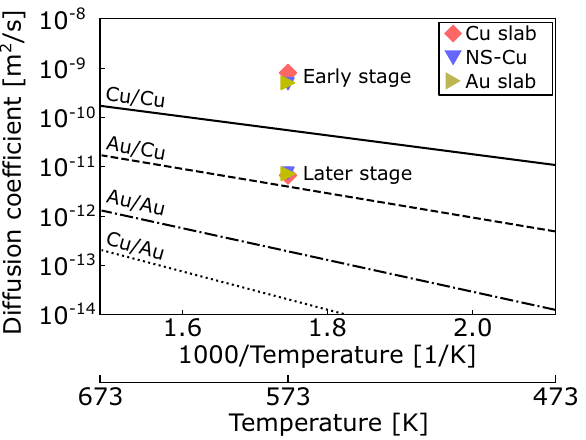
Figure 8. Diffusion coefficient of the Cu slab (red), NS-Cu (blue), and Au slab (yellow) at S v = 2.8 nm −1 during the early stage (t = 10–250 ps) and later stage (t = 400–1005 ps). Surface self-diffusion coefficient of Cu/Cu(100) and Au/Au(100) and surface hetero-diffusion coefficient of Au/Cu(100) and Cu/Au(100) were inserted via the calculation using references 35,36